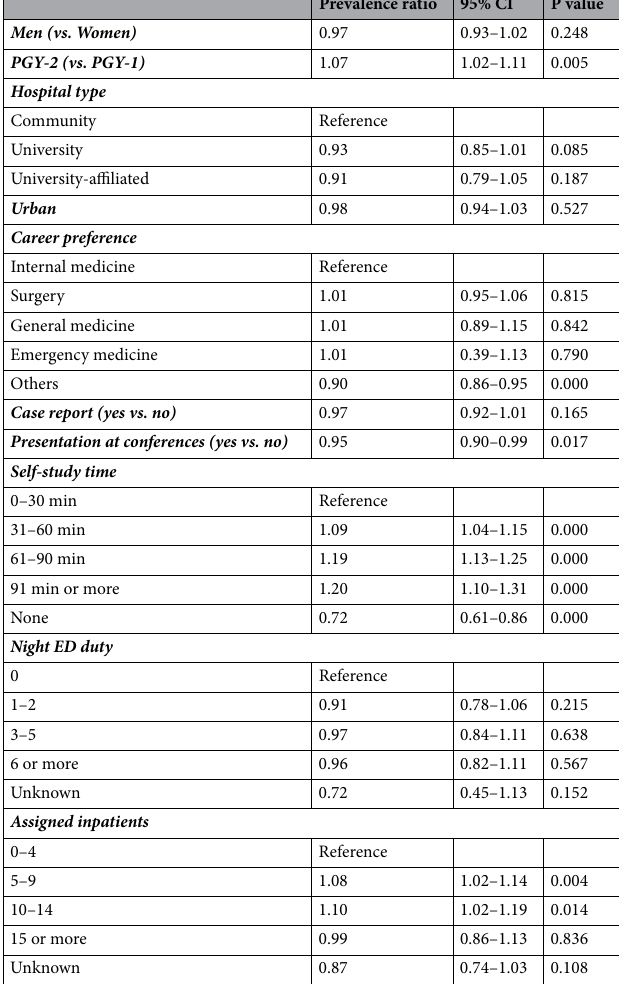
Table 3. Estimates of the ratios of proportions satisfied among residents’ and their hospitals’ characteristics. PGY, postgraduate year; ED, emergency department.